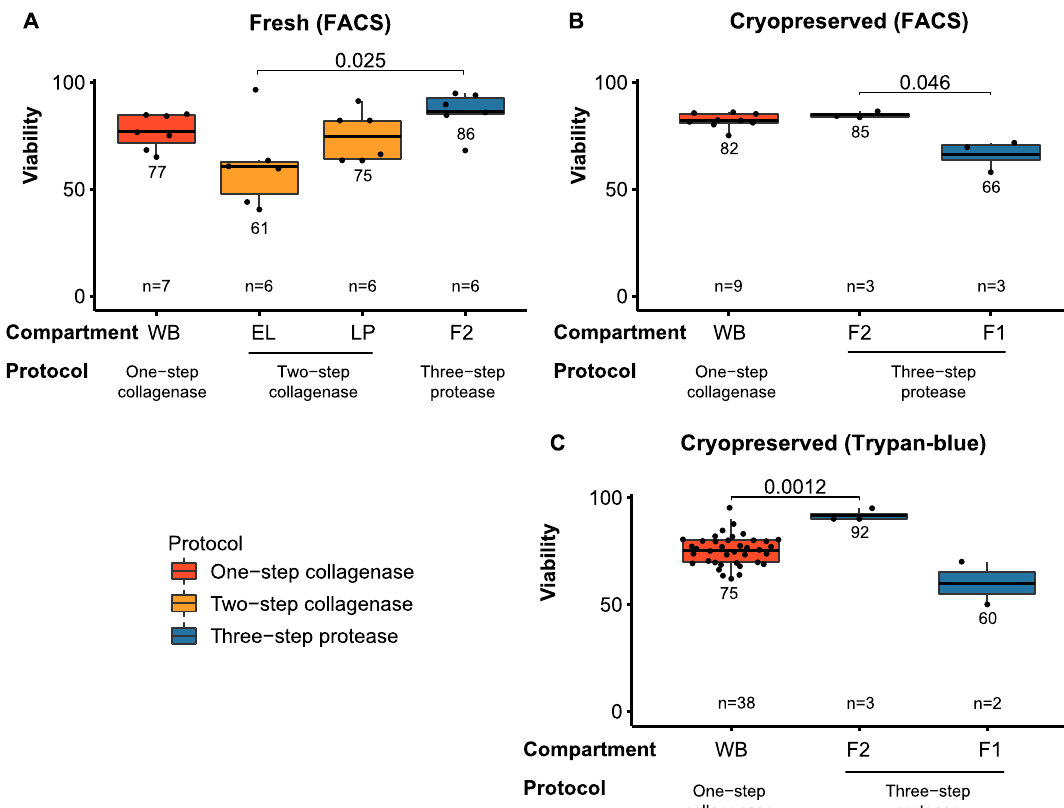
Figure 3. Effect of dissociation protocols on cell viability assessed by FACS and hemocytometry. Boxplots comparing cell viability (%) in ( A ) fresh samples measured by FACS; and cryopreserved samples measured by ( B ) FACS and ( C ) trypan-blue exclusion. Compartments and dissociation protocols are indicated on the x-axis. The average cell viability was compared between compartments (non-paired t-test). Only significant comparisons (p-value < 0.05) are shown as a bar, and the respective p-value, above the compared compartment. Sample size is depicted in the lower part of each plot. WB, whole biopsy; EL, epithelial layer; LP, lamina propria; F1, fraction 1; F2, fraction